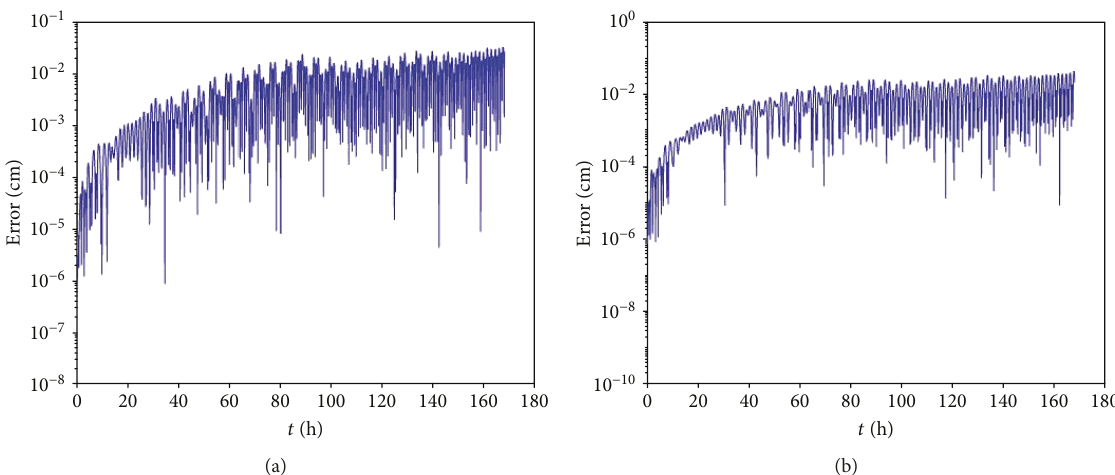
Figure 6: Di ff erence between the ode45 MATLAB and the SODE solutions for the Newtonian (a) X coordinate and (b) Y coordinate, with =10 − 13 and TOL =10 − 16 . The scale is semilogarithmic. TOL r a